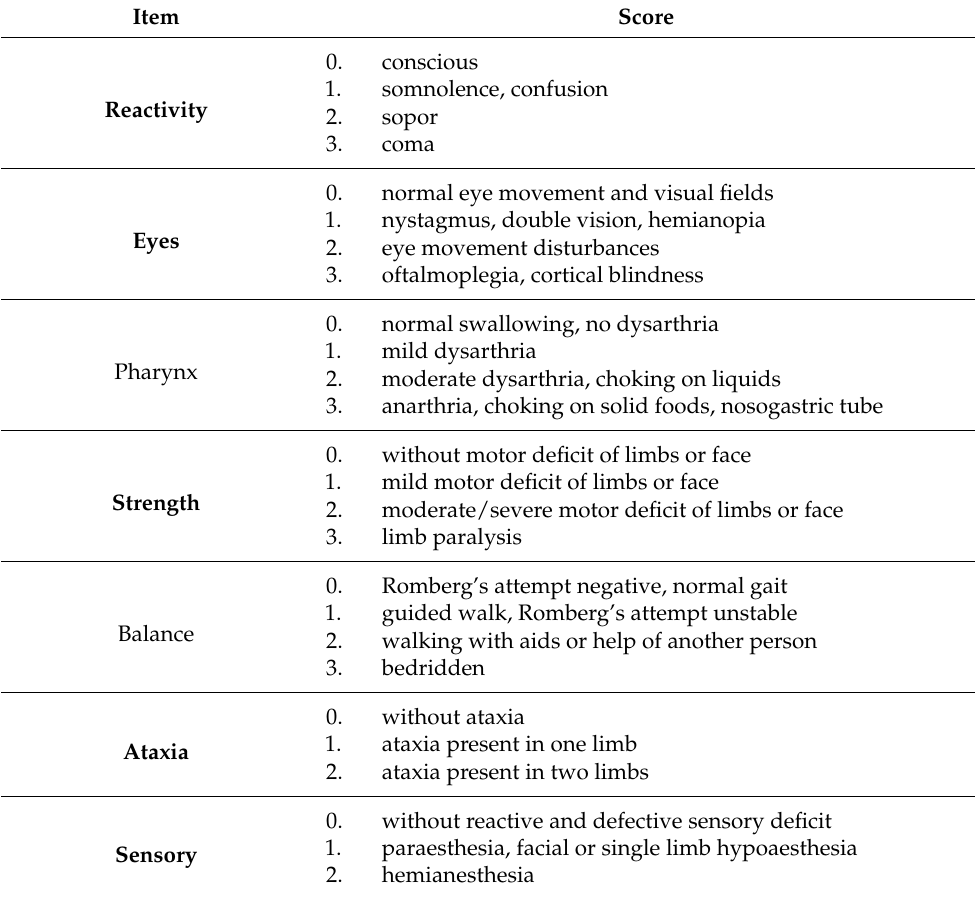
Table 1. Adam’s Scale of Posterior Stroke